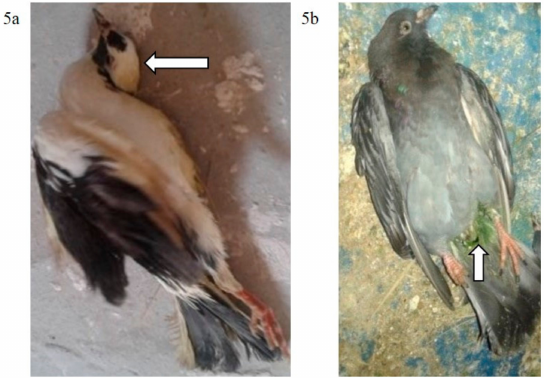
Figure 5. ( a ): Torticollis in a pigeon infected IM with NDV-VIId (G3p); ( b ): Greenish diarrhoea in a pigeon infected IN with NDV-VIId